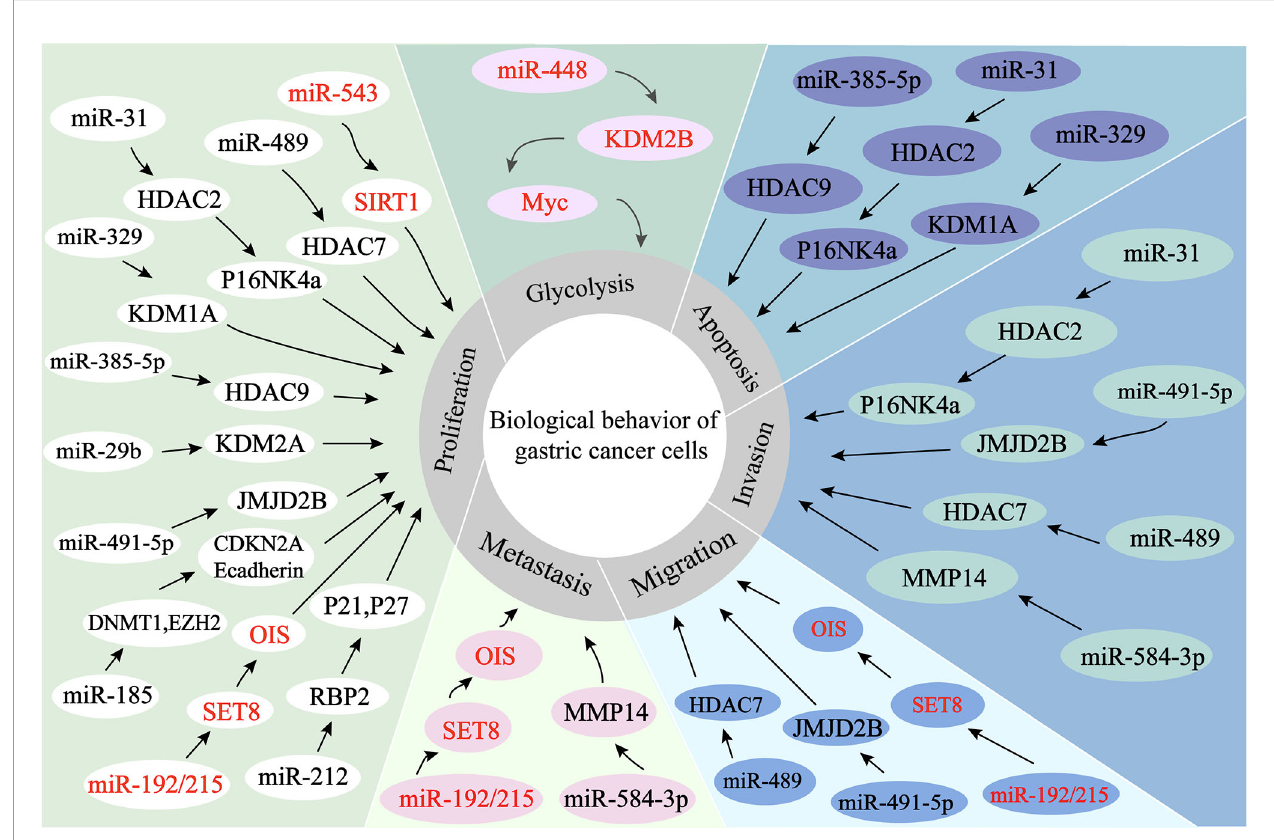
FIGURE 4 | miRNAs regulate histone modi fi cation in GC. 1. miR-584-3P recruits EZH2 and EHMT2 to the MMP-14 promoter, thereby inhibiting the expression of MMP-14 and ultimately exerting its oncogenic effects. 2. miRNAs directly target histone modi fi ers and affect the alteration of histone or non-histone modi fi cations patterns, ultimately leading to changes in the biological behaviors of gastric cancer